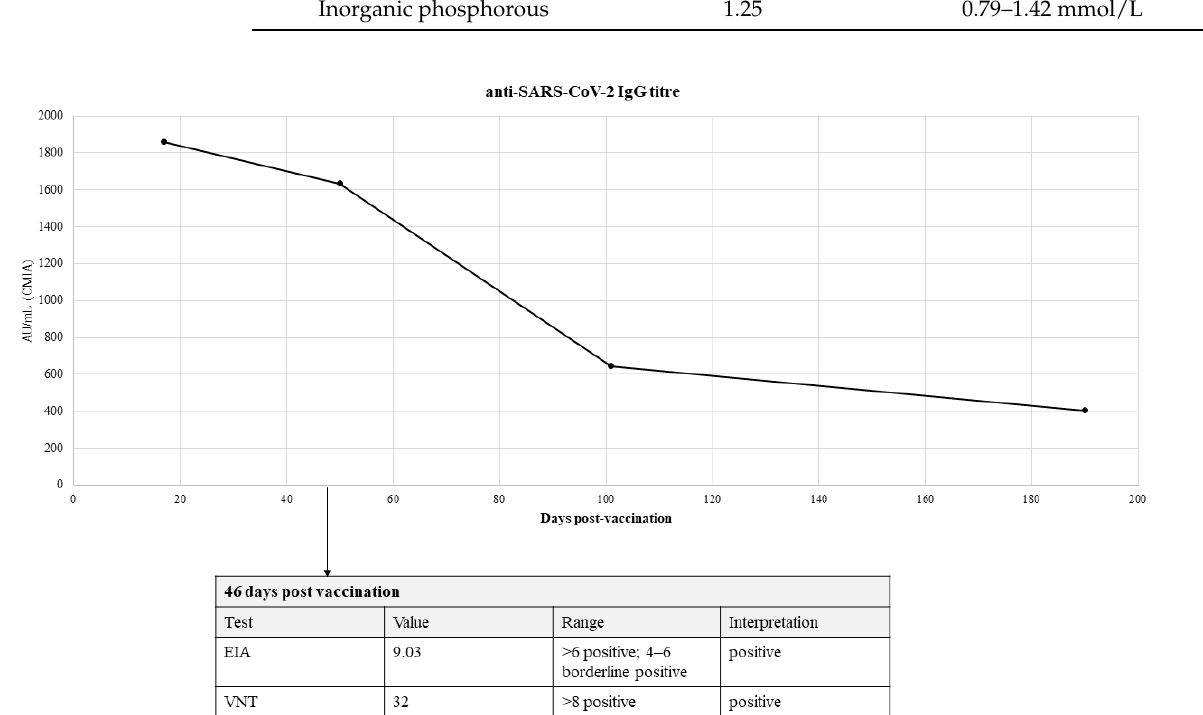
Figure 2. Anti-SARS-CoV-2 IgG titer determined in a private medical laboratory based on a test using chemiluminescent microparticle immunoassay (CMIA) technology. Cut-off value: positive if titer is higher than 50 AU/mL. Enzyme immunoassay (EIA) test for anti-SARS-CoV-2 titer expressed as AI/mL and virus neutralization test (VNT) for SARS-CoV-2 were performed 46 days